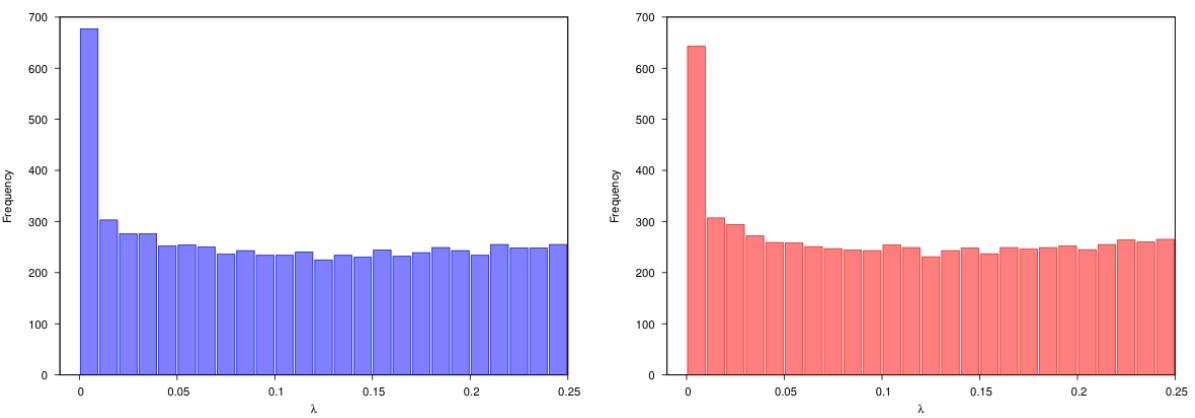
Figure 9. Eigenvalue spectrum of the Overlap Dirac operator for QCD with a physical pion mass, on 24 3 × 6 lattice for µ I = 0.5,1.5 µ I , left and right diagram. From Ref. c